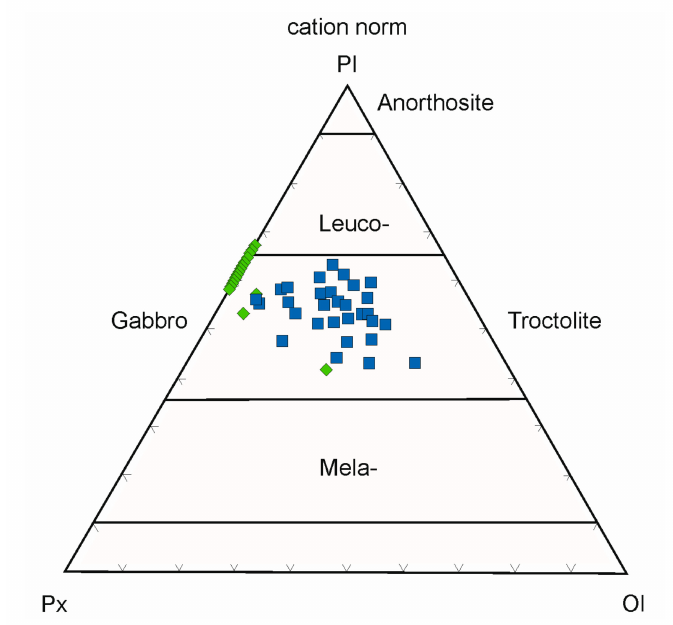
Figure 5. Px–Pl–Ol diagram for the Turumakit area rock compositions, where: blue squares and green diamonds correspond to samples from Norilsk and Ergalakh intrusions,